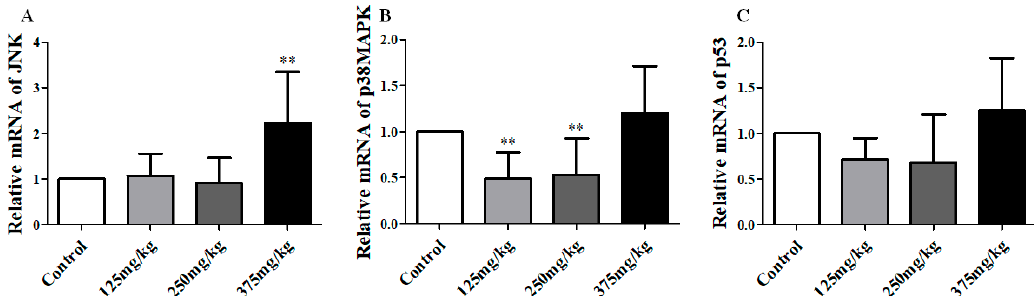
Figure 5. Effect of DEHP exposure on the mRNA expression of JNK/p38MAPK/p53 in liver of mice ( n = 3). ( A ) The mRNA expression of JNK; ( B ) The mRNA expression of p38MAPK; ( C ) The mRNA expression of p53. Data represented as means ± SD, * p < 0.05, ** p < 0.01 compared with the control group. The protein expressions of the JNK, p-JNK, p38MAPK, p-p38MAPK, and p53 are shown in